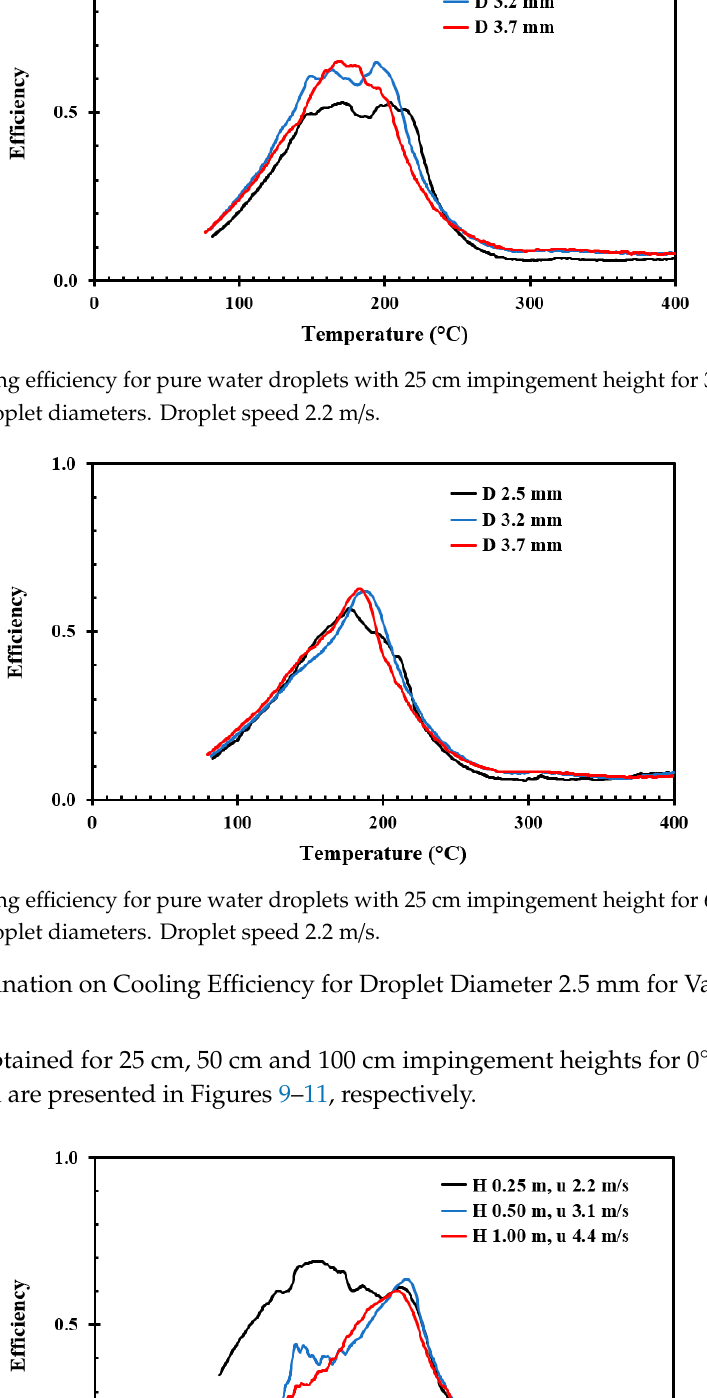
Figure 10. Cooling efficiency for pure water droplets at 30° disc inclination, droplet diameter 2.5 mm. Impingement heights and speeds are given in the figure label. Figure 11. Cooling efficiency for pure water droplets at 60° disc inclination, droplet diameter 2.5 mm. Impingement heights and speeds are given in the figure label. For impingement height 25 cm, the results indicate that horizontal orientation gave the highest cooling efficiency at temperatures of about 150 °C. This may be due to droplets remaining on the surface for a longer period. For inclined surfaces, increasing impingement height seems to increase cooling efficiency, though the cooling efficiency curves cross for parts of the investigated temperature range. Similar results were obtained for droplet diameter 3.2 mm and 3.7 mm (results not included).